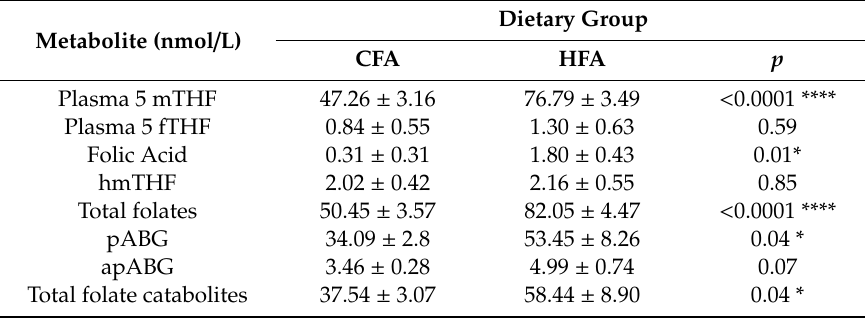
Table 1. Plasma folate, folic acid (FA) and folate metabolite concentrations after the end of the 4-week dietary intervention (PND (post-natal day) 102). Values are mean ± SEM for n = 8 mice per group. Statistical comparisons were by Student’s unpaired T -test. CFA, control folic acid; HFA, high folic acid. Total folate concentration was calculated form the sum of the concentrations of 5-methyltetrahydrofolate (mTHF), 5-formyltetrahydrofolate (5-fTHF), hydroxymethyltetrahydrofolate (hmTHF) and FA. Total folate catabolites were calculated from the sum of para-aminobenzoylglutamnate (pABG) and acetyl para-aminobenzoyl glutamate (acpABG). n = 8 females per diet group. Statistical analysis was by Student’s unpaired T -test. * p < 0.05 and **** p <